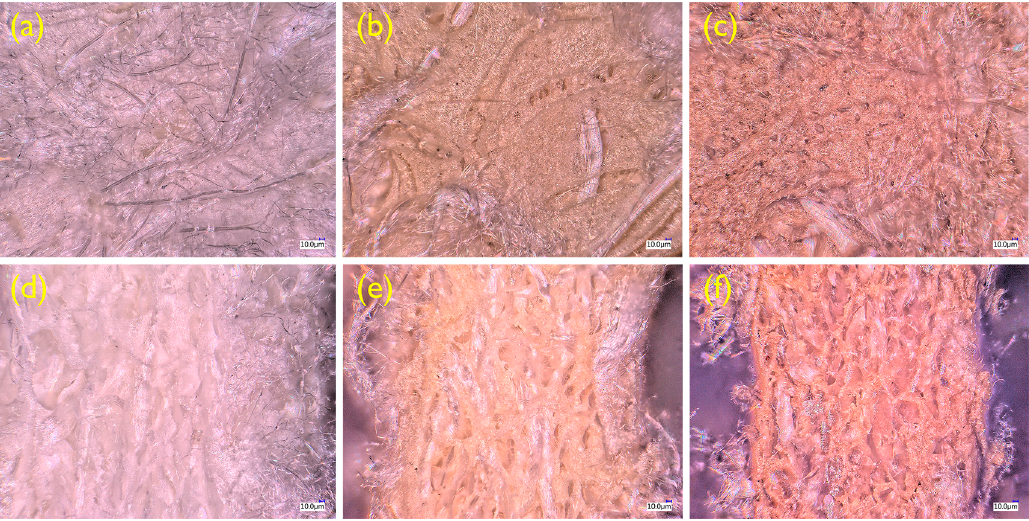
Figure 9. Focus stacked images of the surface and cross-section for ( a , d ) R-RM nonwoven, ( b , e ) R-RM nonwoven dyed at 100 °C , and ( c , f ) R-RM nonwoven dyed at 140 °C .